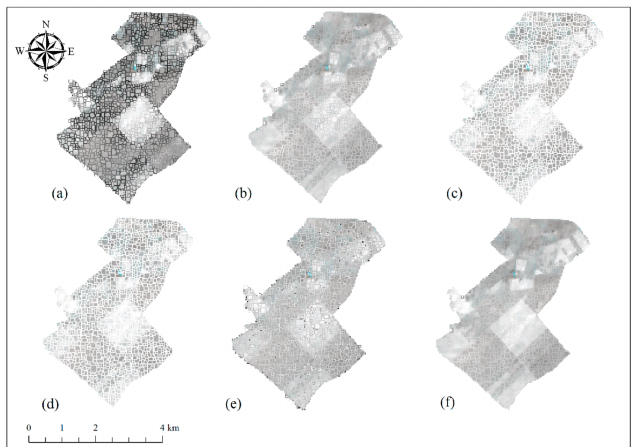
Figure 7. Applying band ratio feature functions on the Sentinel-2 image: ( a ) band 5, ( b ) band 6,